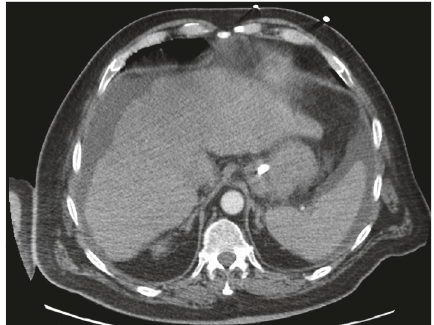
Figure 3: Transverse section of upper abdominal viscera; images acquired during CTPA.